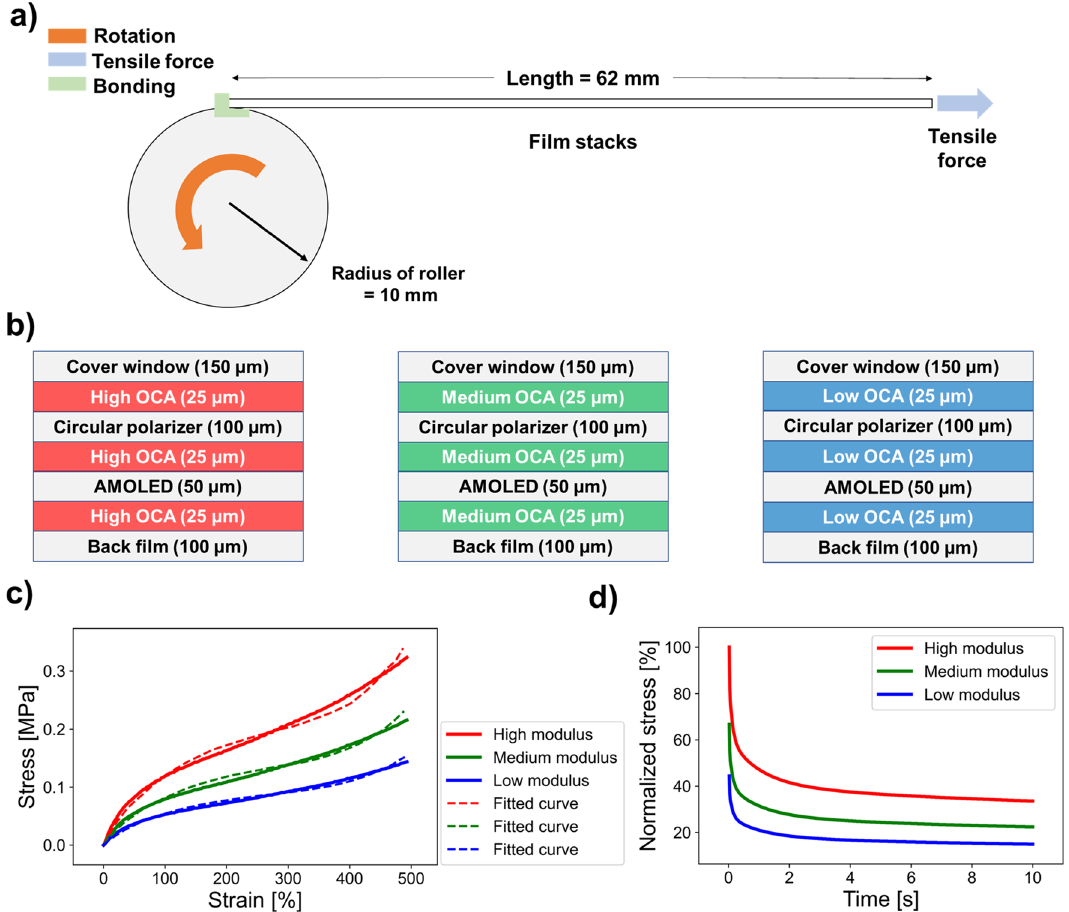
Figure 2. ( a ) Mechanical structure and boundary conditions of rollable displays. ( b ) Schematic of display film stack modules according to the modulus conditions of OCA. ( c ) OCA’s stress–strain curves with high, medium, and low modulus and fitted curves based on the use of the hyperelastic constitutive model. ( d ) Stress relaxation of OCA with high, medium, and low modulus at constant tensile strain.